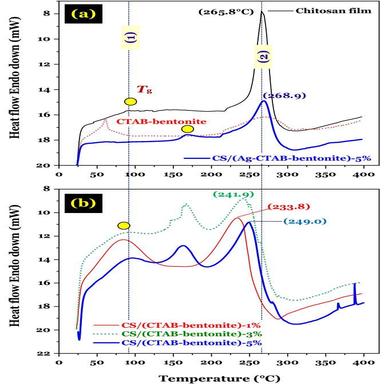
DSC thermograms: (a) CTAB-bentonite, pure chitosan film, and CS/(Ag-CTAB-bentonite)-5% film; and (b) three films: CS/(CTAB-bentonite)-1%, CS/ (CTAB-bentonite)-3%, and CS/(CTAB-bentonite)-5%.